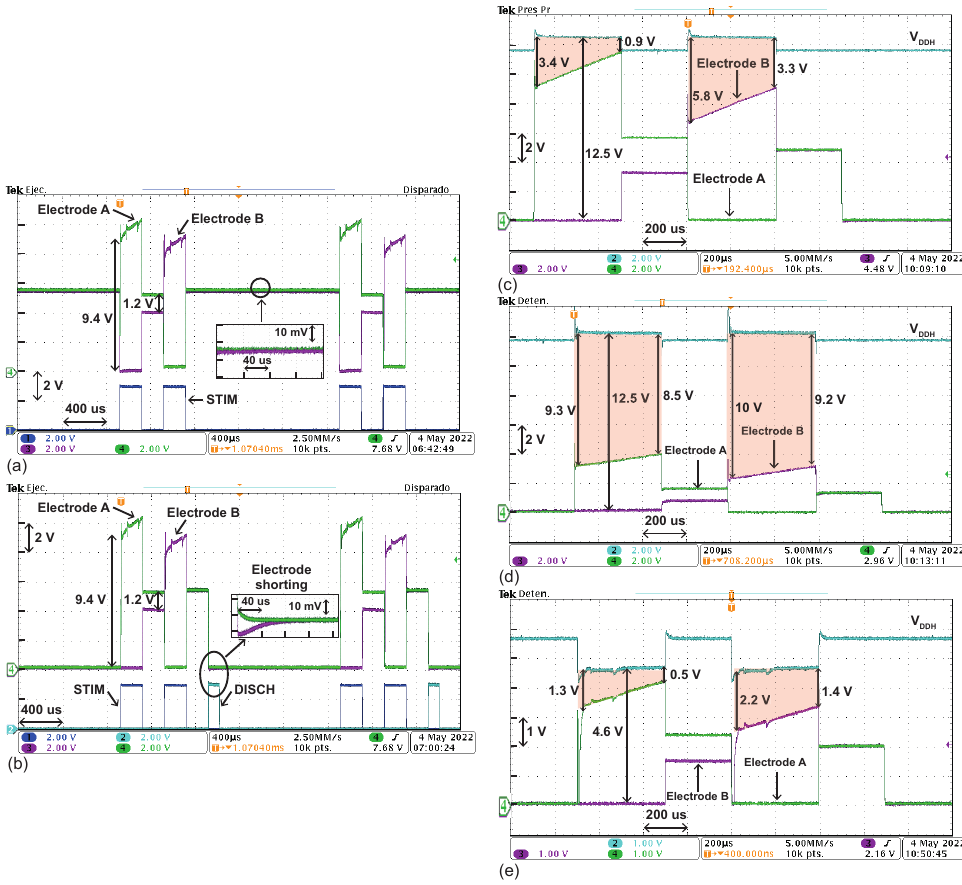
Figure 13. ( a , b ) Electrodes’ voltages when a 2mA stimulation current is delivered with/without electrode shorting phase. T an / ca = T int = 200µs and V DDH = 12V. ( c – e ) Electrodes’ voltages and DC-DC converter output voltage at different stimulation timing and currents. Voltage drop between V DDH and stimulator’s output is shaded in